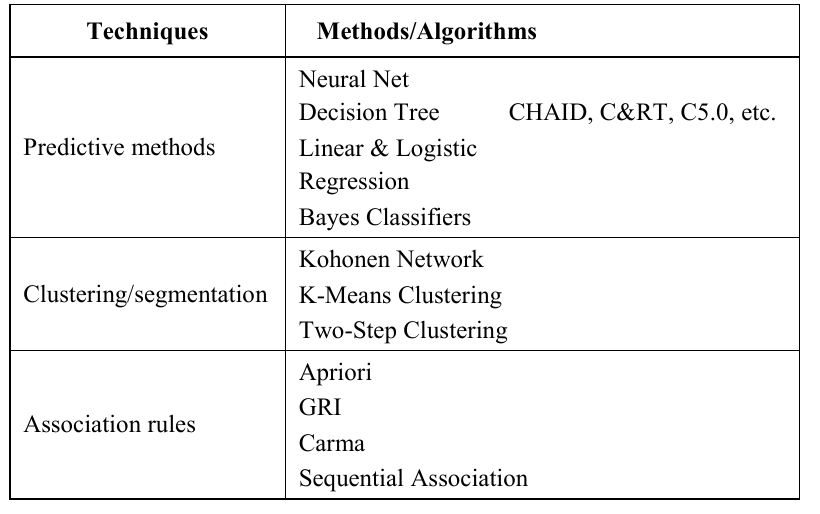
Table 1. Data Mining